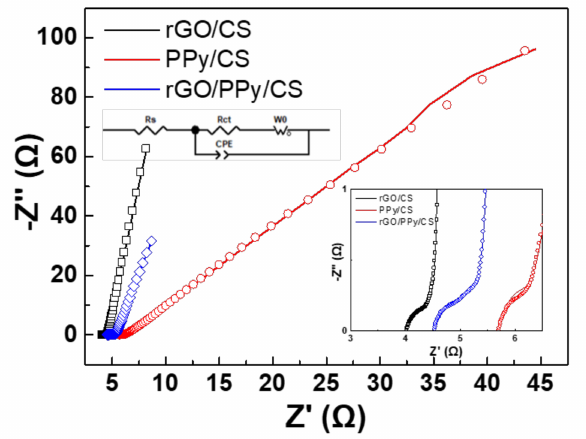
Figure 4. Nyquist plots of SCs with rGO/CS, PPy/CS, and rGO/PPy/CS nanocomposites.